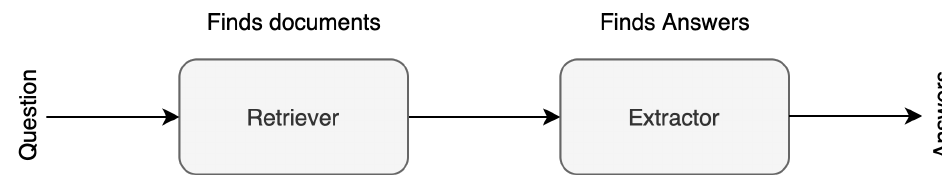
Figure 1. High-level workflow of the solution in one pass. Table 2. Our solution with an